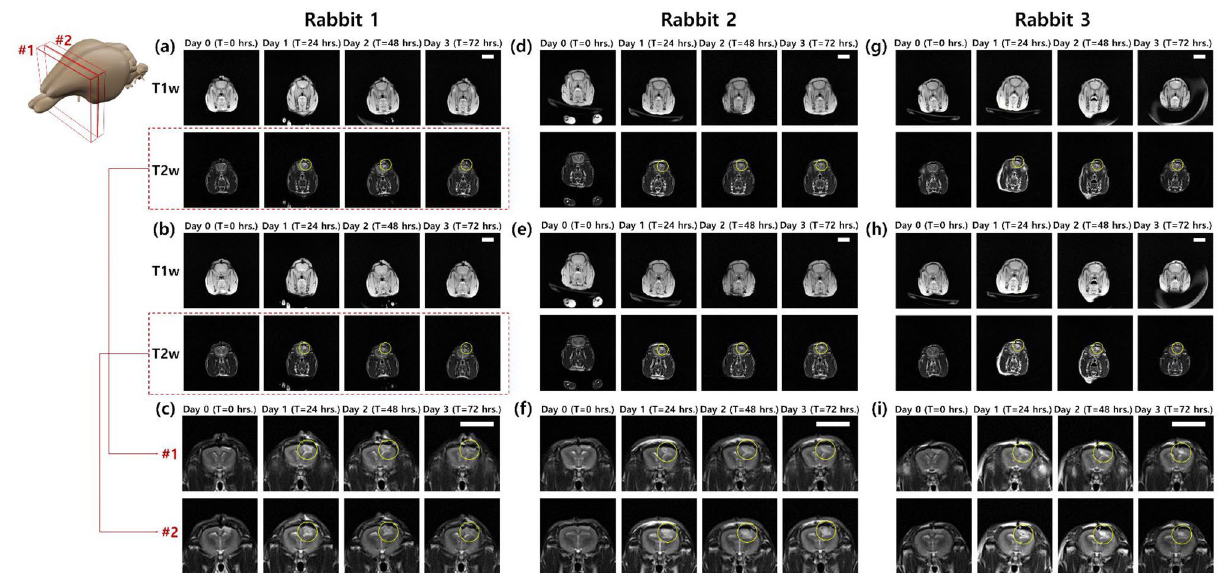
Figure 3. Transient ( a ) T1-, ( b ) T2-weighted, and ( c ) magnified T2-weighted magnetic resonance images of two brain slices (#1 and #2) of Rabbit 1 obtained immediately, 24, 48, and 72 h after the investigation